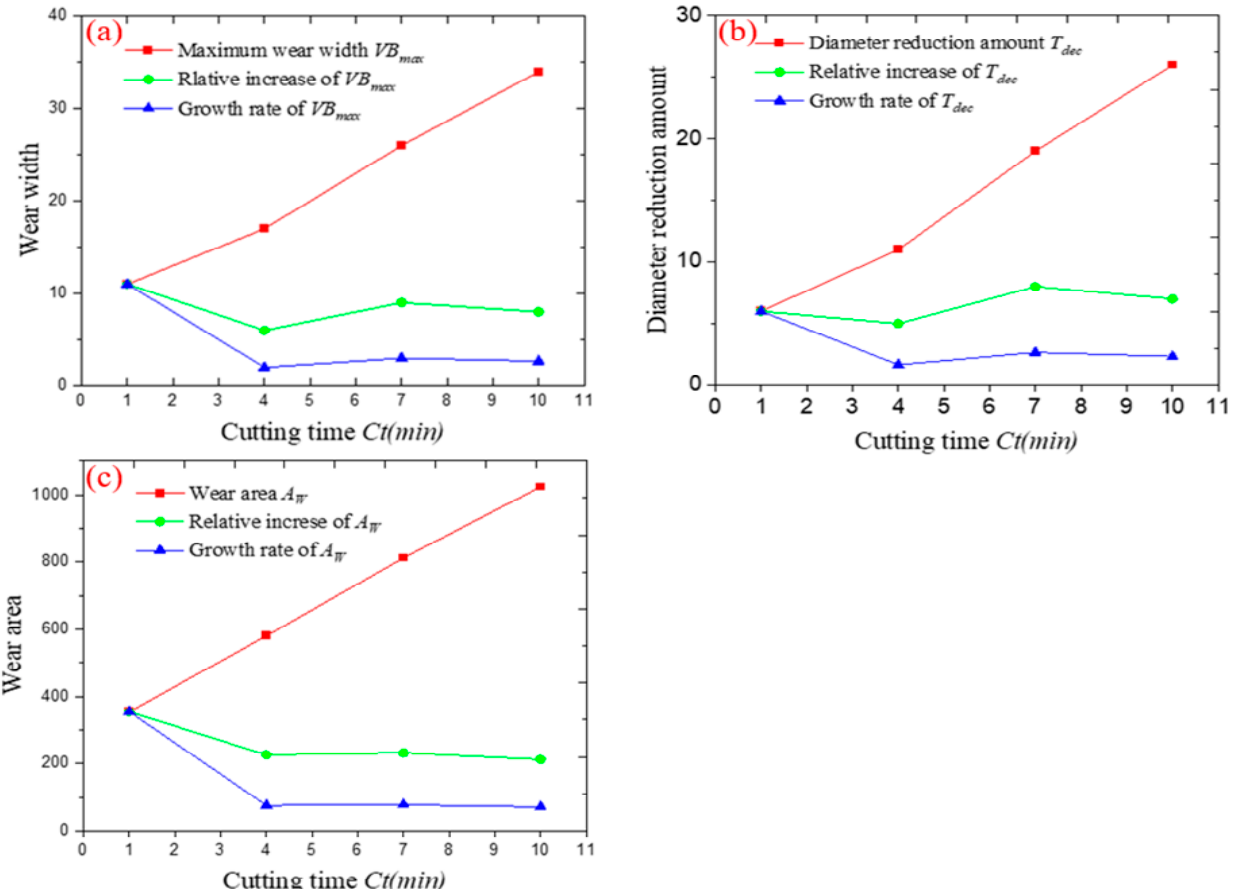
Figure 19. Change tendency chart of wear evaluation indicator of tool No. 2: ( a ) change tendency chart of maximum wear width 𝑉𝐵 max ; ( b ) change tendency chart of diameter reduction 𝑇 (cid:3031)(cid:3032)(cid:3030) ; ( c ) dency chart of maximum wear width VB max ; ( b ) change tendency chart of diameter reduction T dec ; change tendency chart of wear area A W . ( c ) change tendency chart of wear area A W